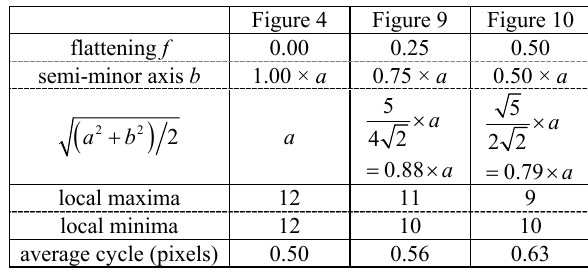
Table 3. Number of local maxima and local minima, and the average cycle of the oscillation of the measurement accuracy by CM (12 pixels  a  18 pixels,  =